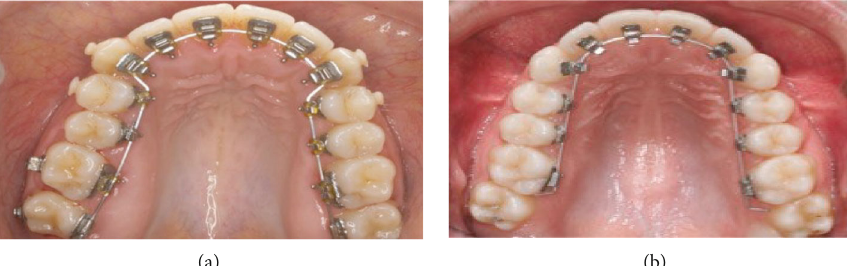
Figure 2: Standardized arches for the lingual technique: (a) mushroom shape and (b) straight. The choice of the type of arch is according to the criteria and experience of the orthodontist.